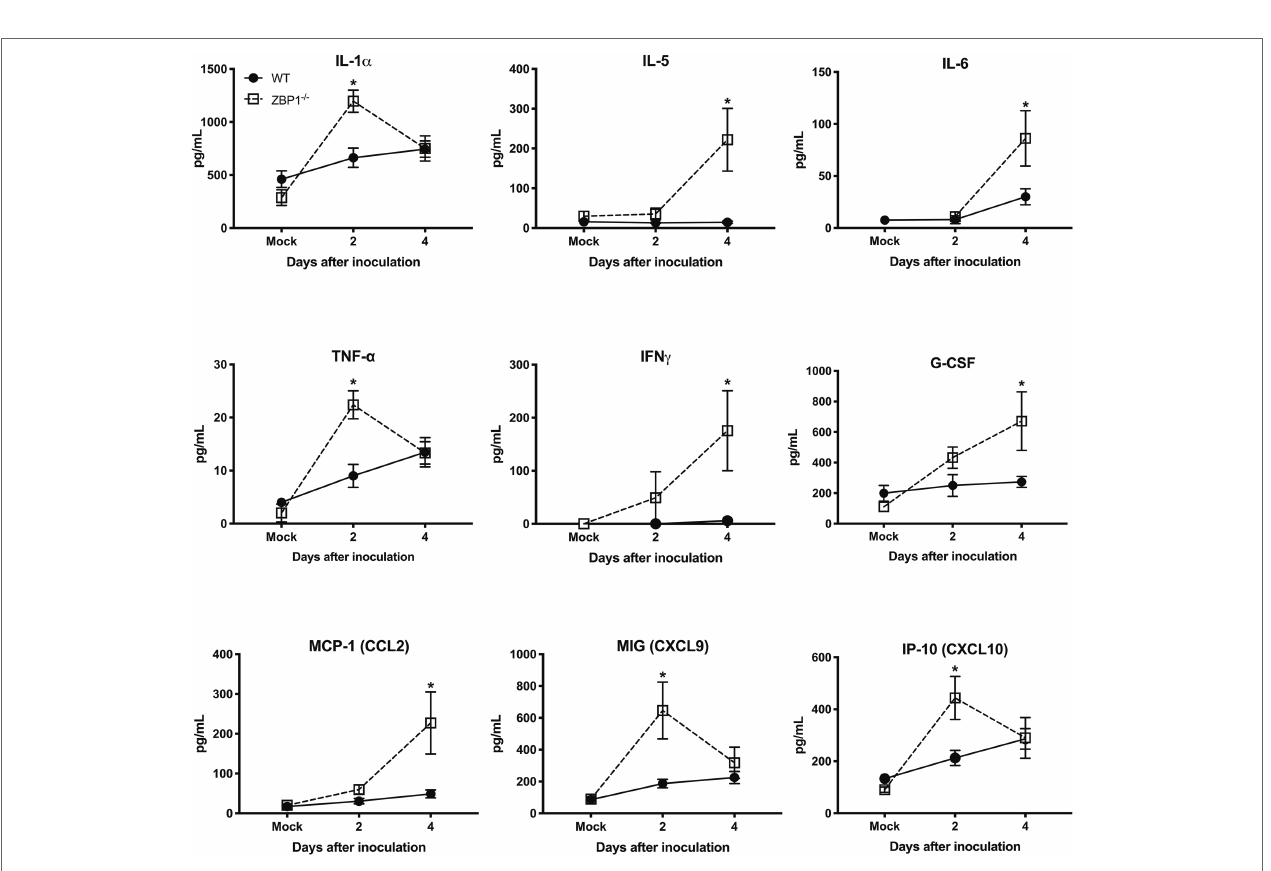
FIGURE 4 | Protein levels of cytokines and chemokines in the serum of WT and ZBP1 −/− mice after infection with WNV NY99. Levels of cytokines and chemokines were measured in the serum of WNV NY99-infected WT and ZBP1 −/− at days 2 and 4 after infection. Data represent the mean concentration (pg/ml) ± SEM ( n = 6–7 mice per group). * p <